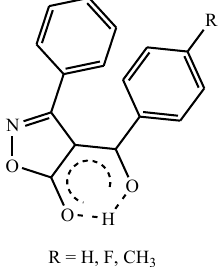
Figure 1. 4-Aroyl-3-phenyl-5-isoxazolones (HA).